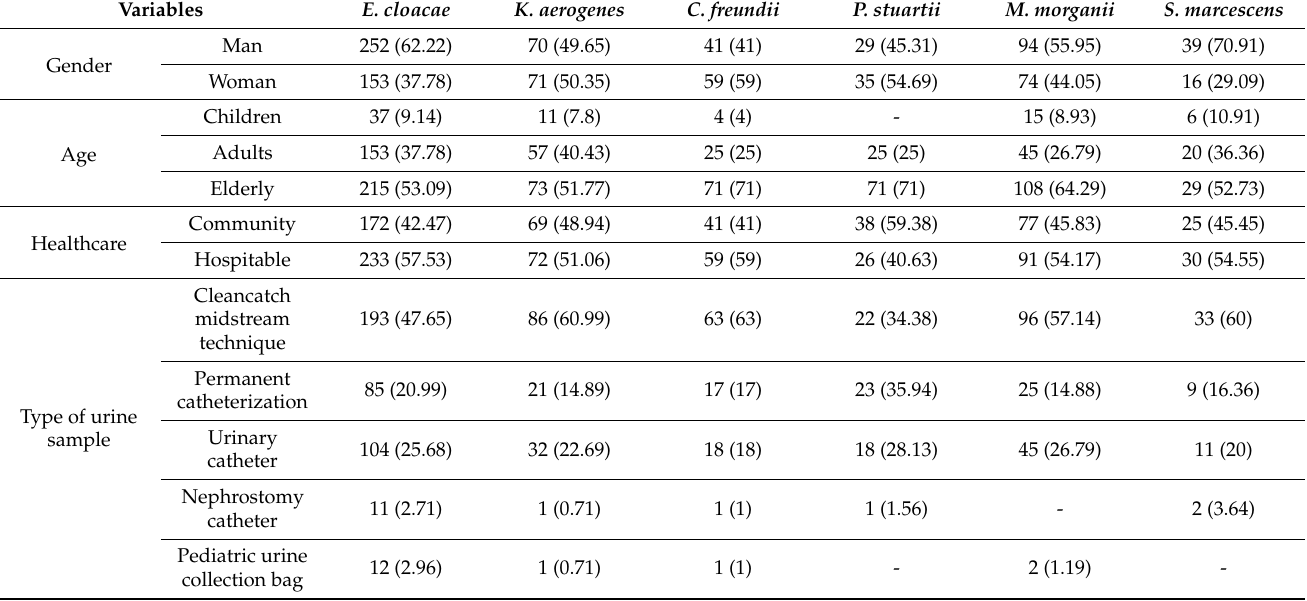
Table 2. Number and percentage of clinical isolates for each